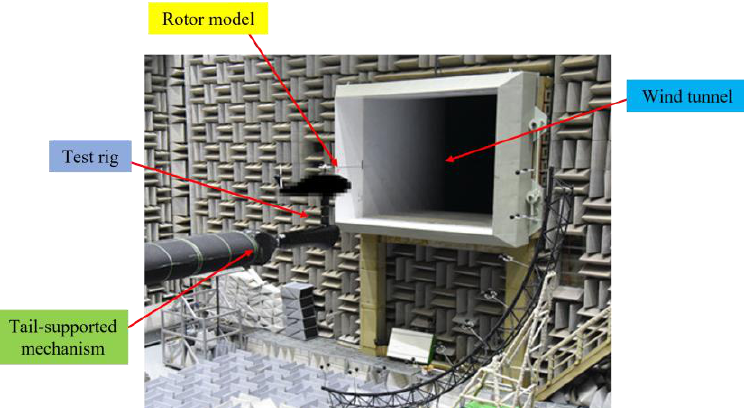
Figure 6. The Ф 3m tail-supported helicopter rotor model wind tunnel test rig. Figure 6. The φ 3m tail-supported helicopter rotor model wind tunnel test rig.